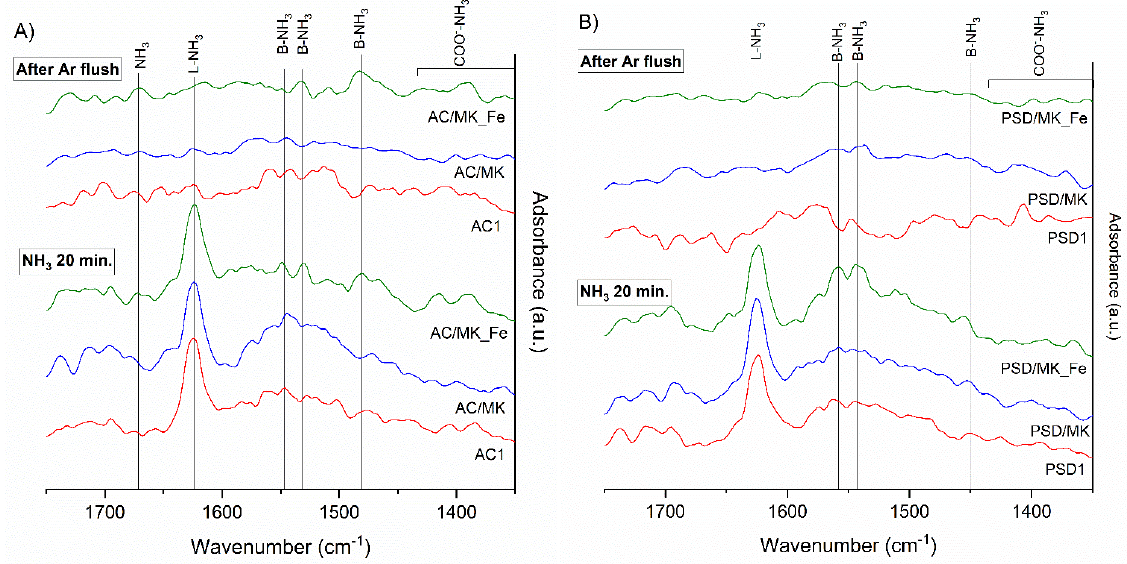
Figure 2. DRIFT spectra after 20 min ammonia adsorption and after 5 min Ar flush over ( A ) activated carbon (AC) and ( B ) carbonized biomass materials. Abbreviation “B” indicates Brønsted acid site and “L” Lewis acid site.